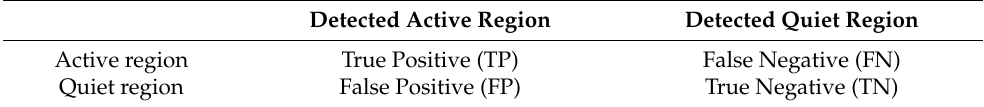
Table 2. Contingency table for active region